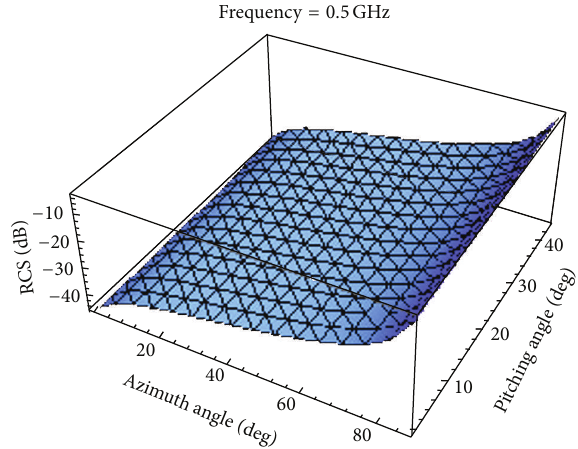
Figure 7: Backscattered RCS for an elliptical cylinder for 𝜃, 𝜑 of ̂𝑚 = 16.